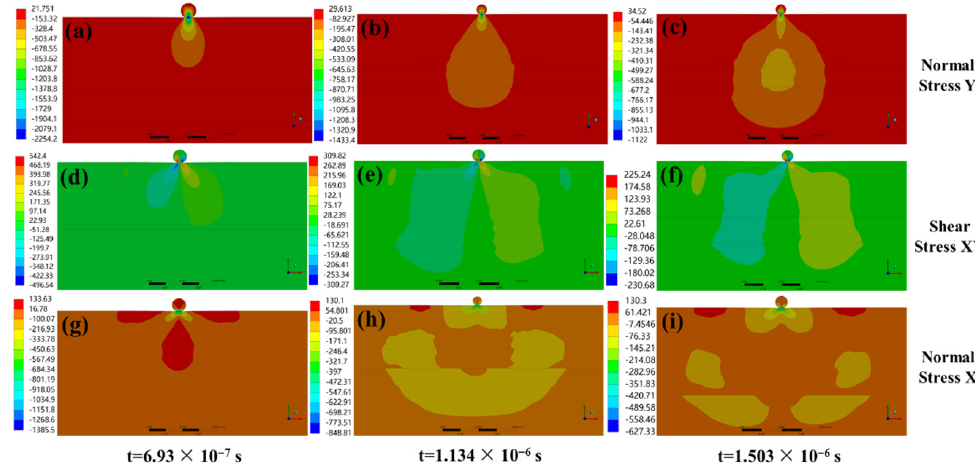
Figure 7. The contour plot of ( a – c ) normal stress Y, ( d – f ) shear stress XY and ( g – i ) normal stress X at different times when the impact velocity equal to 100 m/s and the impact angle equal to 90°.